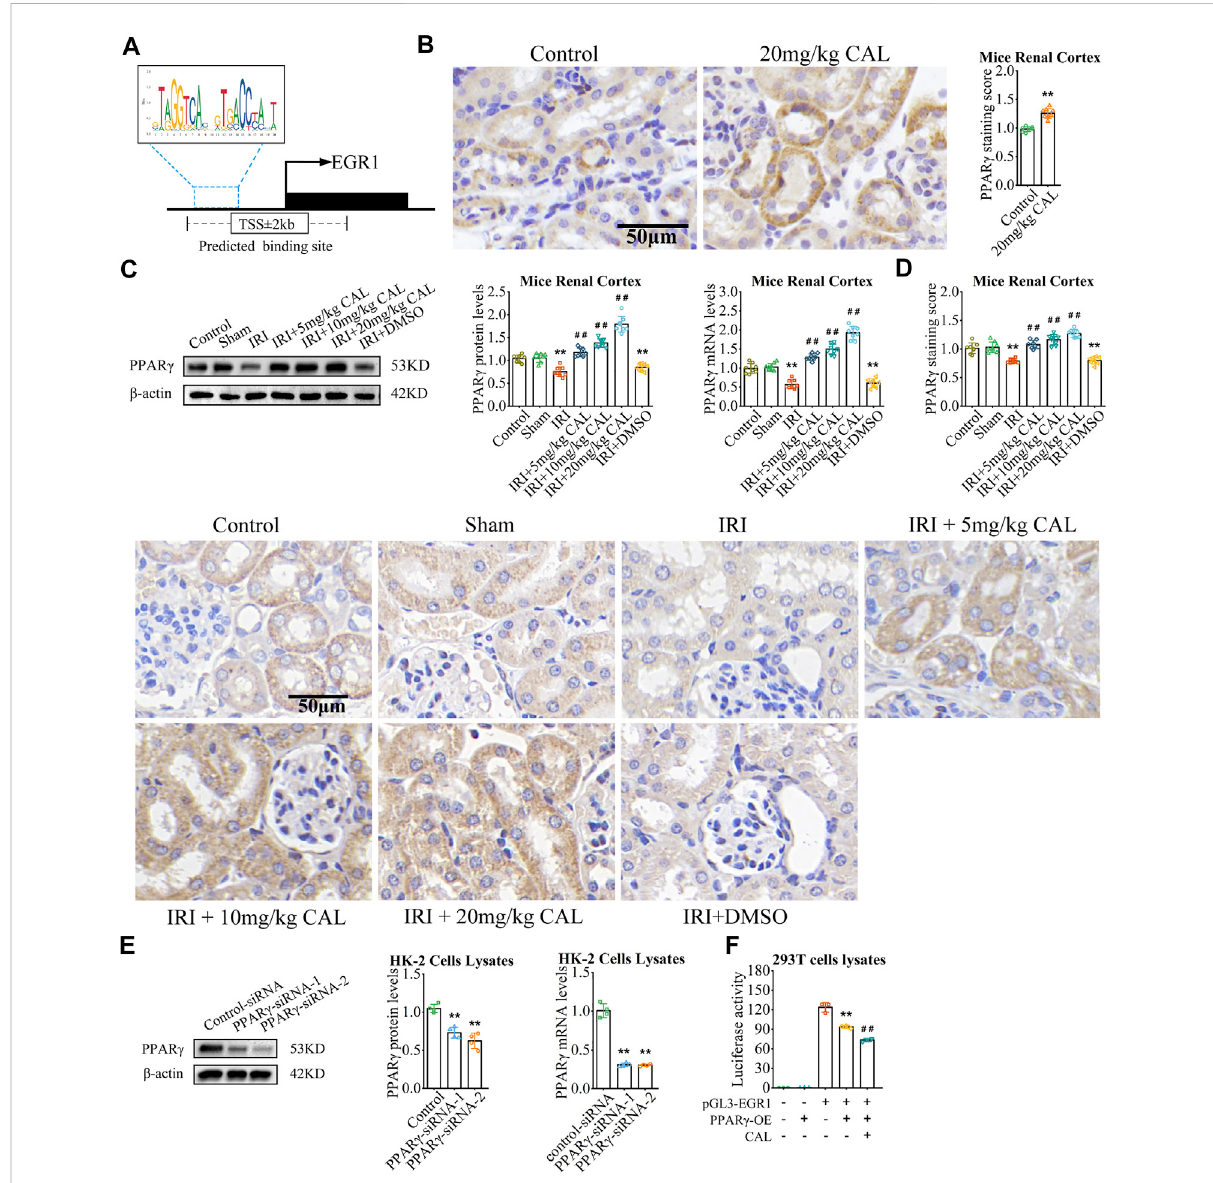
FIGURE 4 PPAR γ targeted and inhibited EGR1. (A) The binding sites of PPAR γ between EGR1 promoter region predicted by JASPAR website. (B) Immunohistochemistry showed the expression level PPAR γ of kidney tissue samples in normal control group and 20 mg/kg CAL group. Scale bar, 50 µm. ** p < 0.01 vs. control group. n = 3 per group. (C) The PPAR γ mRNA and protein levels in kidney samples of different groups. (D) Immunohistochemistry showed the expression level PPAR γ of kidney tissue samples in different groups. Scale bar, 50 µm. ** p < 0.01 vs. sham group. ## p < 0.01 vs. IRI group. n = 8 per group. (E) The mRNA and protein levels of PPAR γ in HK-2 cells transfected with PPAR γ siRNA or control siRNA. ** p < 0.01 vs. control siRNA group. n = 4 per group. (F) Luciferase reporter assay showed the effect of CAL and PPAR γ on the activities